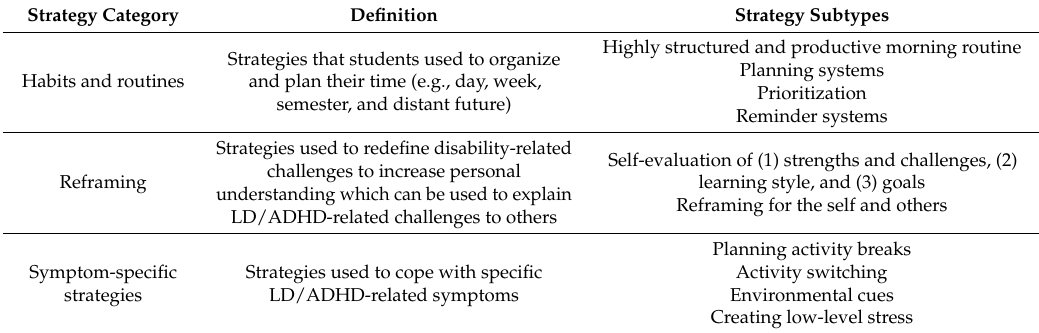
Table 3. Strategies for addressing time-related and productivity